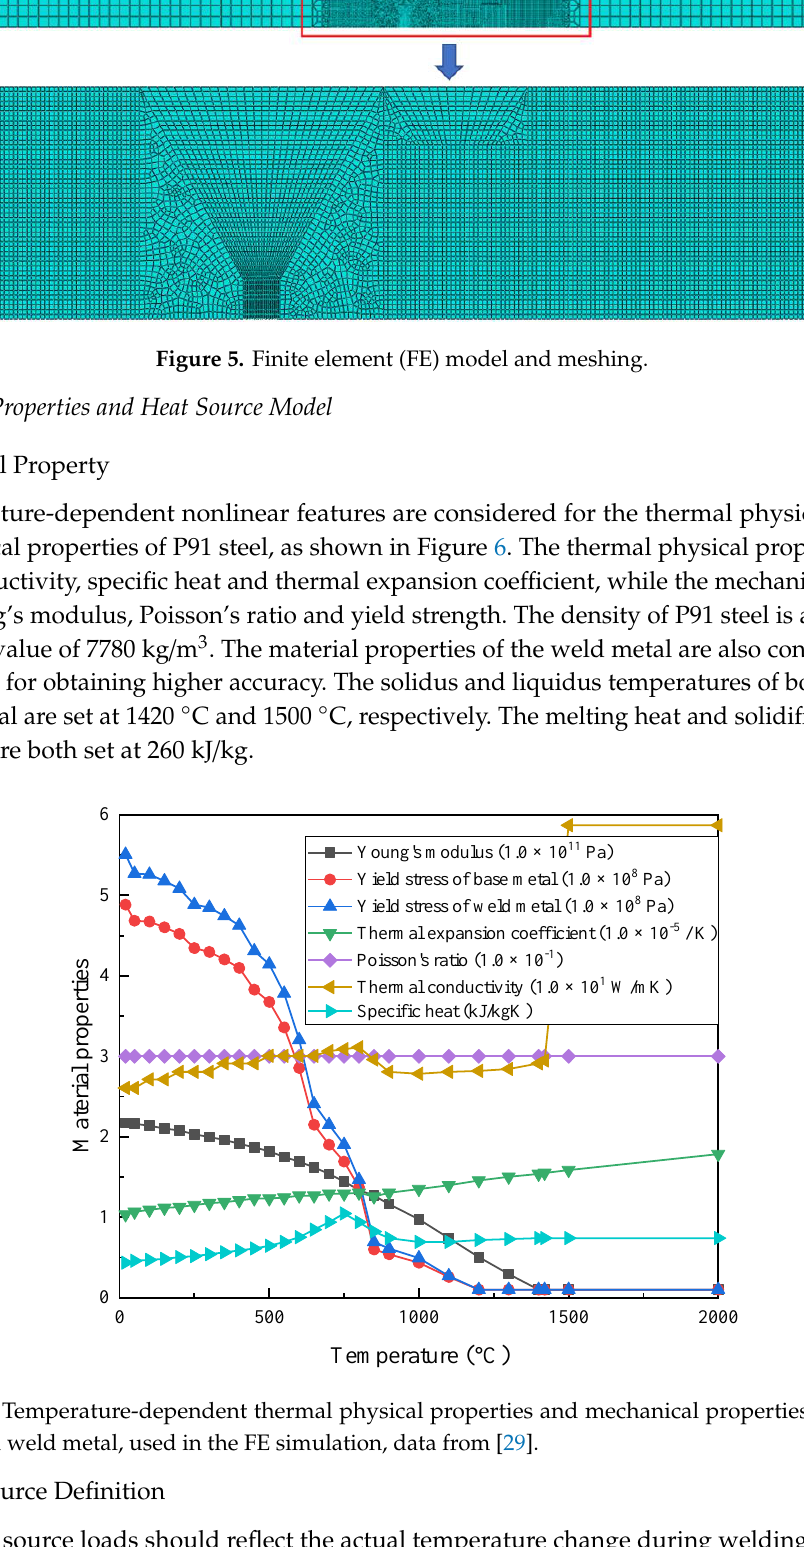
Figure 5. Finite element (FE) model and meshing.